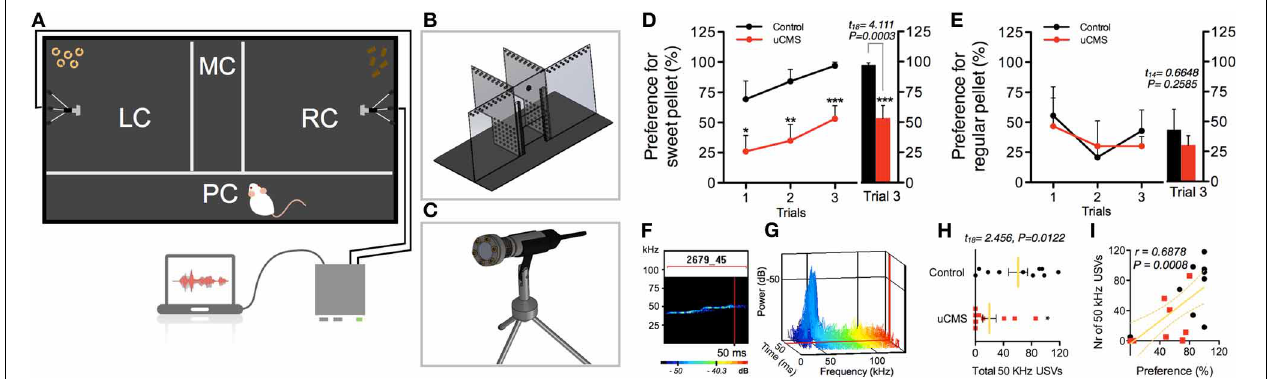
FIGURE 1 | Characterization of anhedonic behavior in rats exposed to uCMS, in the Sweet-Drive Test (SDT) paradigm. (A) Preference for sweet pellets was measured in a compartmentalized SDT apparatus (B) , in which ultrasonicvocalizationswererecordedusingultrasoundmicrophones (C) . (D,E)